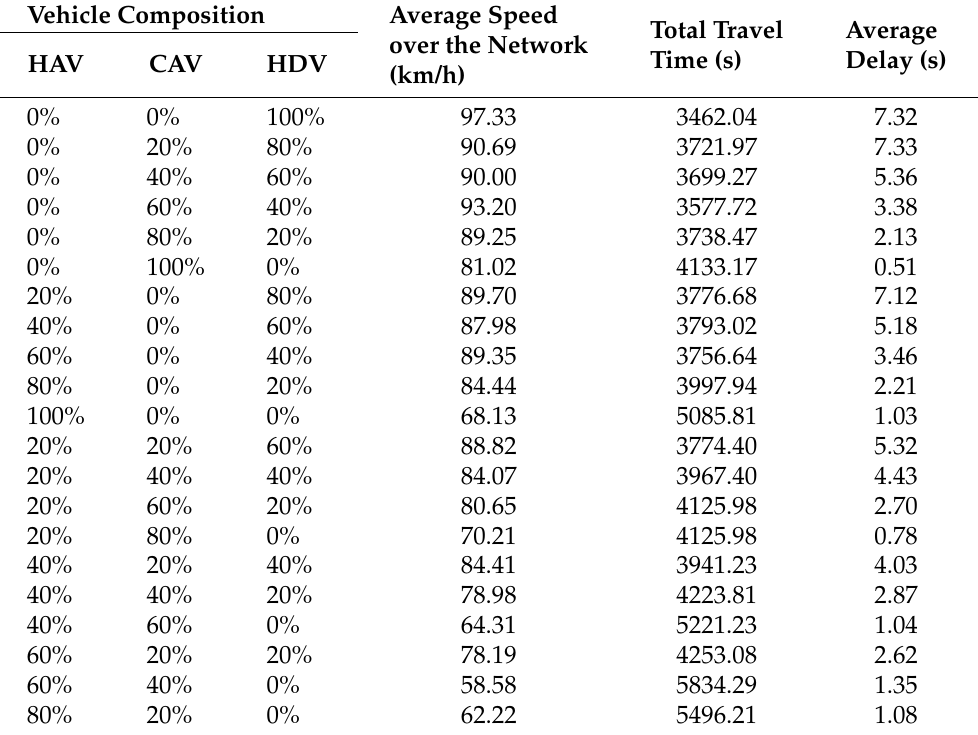
Table 1. Traffic performance evaluation of the simulated